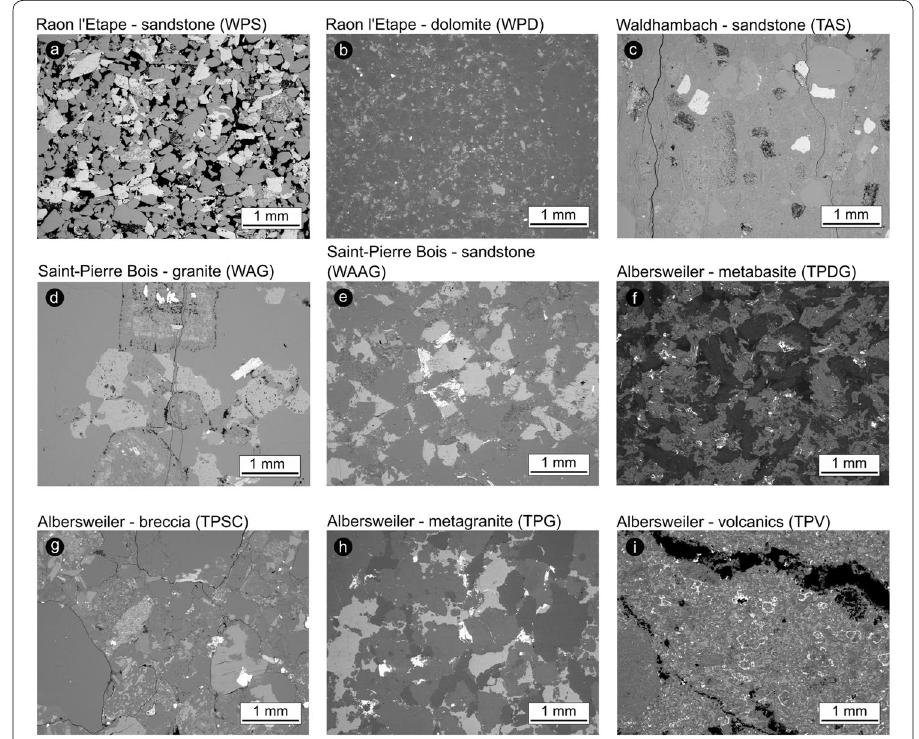
Fig. 4 Backscatter electron microscope images of select rocks characterised in this study. Black space is porosity. a Sandstone (WPS) from Raon l’Etape. b Dolomite (WPD) from Raon l’Etape. c Sandstone (TAS) from Waldhambach. d Granite (WAG) from Saint Pierre Bois. e Sandstone (WAAG) from Saint Pierre Bois. f Metabasite (TPDG) from Albersweiler. g Breccia (TPSC) from Albersweiler. h Metagranite (TPG) from Albersweiler. i Hydrothermally altered Permian volcanics (TPV) from